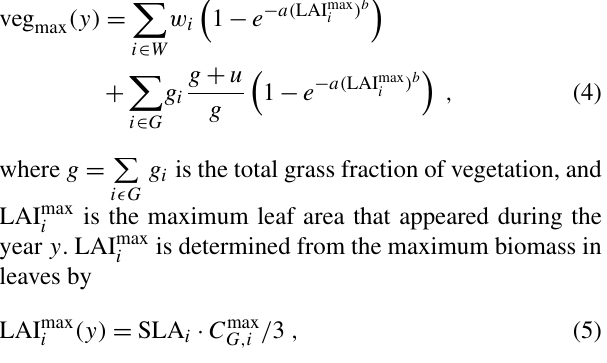
corresponding to a spin-up period to reach a state close to equilibrium; the first 100 years of the spin-up period were run with 3 times the accelerated vegetation dynamics. In the standard JSBACH configuration, the seasonal canopy albedo is calculated as a function of leaf area index, whereas the bare soil albedo is a grid box constant derived from satel- lite measurements (see Otto et al., 2011). To account for darker soils below vegetation, we implement for the study domain (11.19 to 33.57 ◦ N, 15.94 ◦ W to 40.31 ◦ E; see Fig.